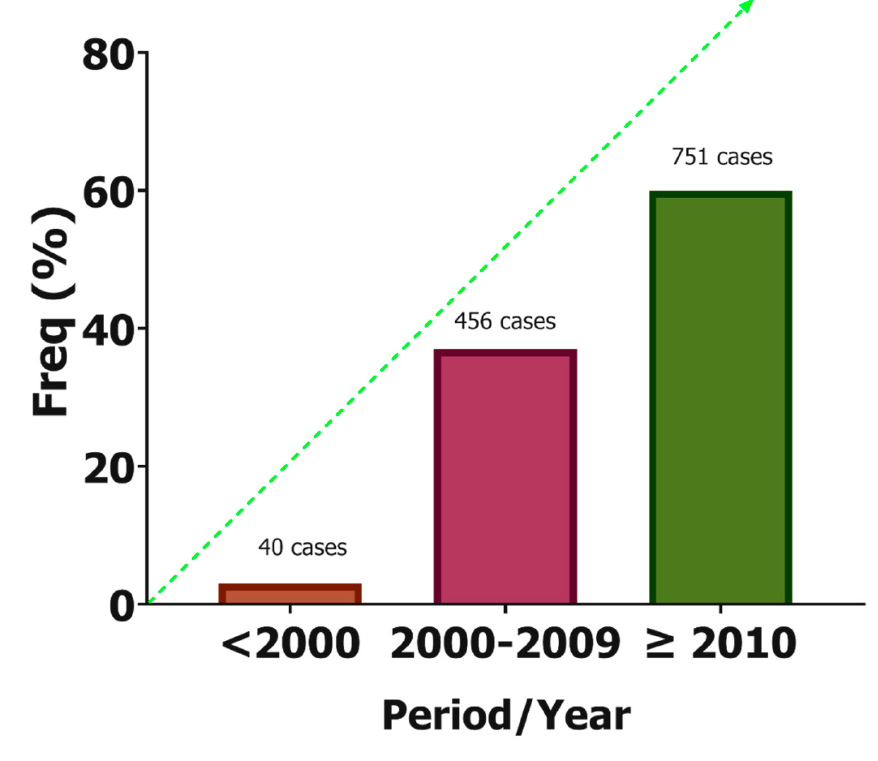
Figure 3. Trends in the report of CPA cases in Africa.